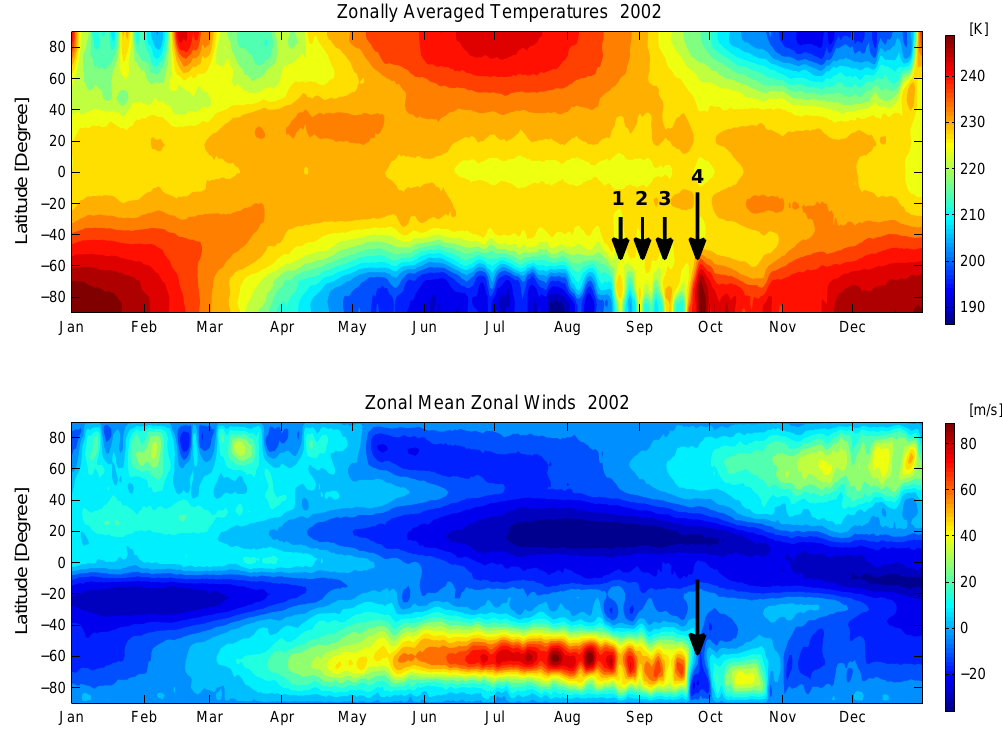
Fig. 3. Top panel: Zonally averaged temperatures from NCEP Reanalysis sampled at 36hPa shown as a function of latitude and universal time. Three minor warming and the major SSW event are marked by arrows. The first three minor warmings were centered on 24 August, 1 September, and 14 September while the major SSW event was centered on 27 September. Bottom panel: Latitude-time cross section of zonal mean zonal winds at 36hPa from NCEP Reanalysis showing the reversal of the wind at the onset of major SSW